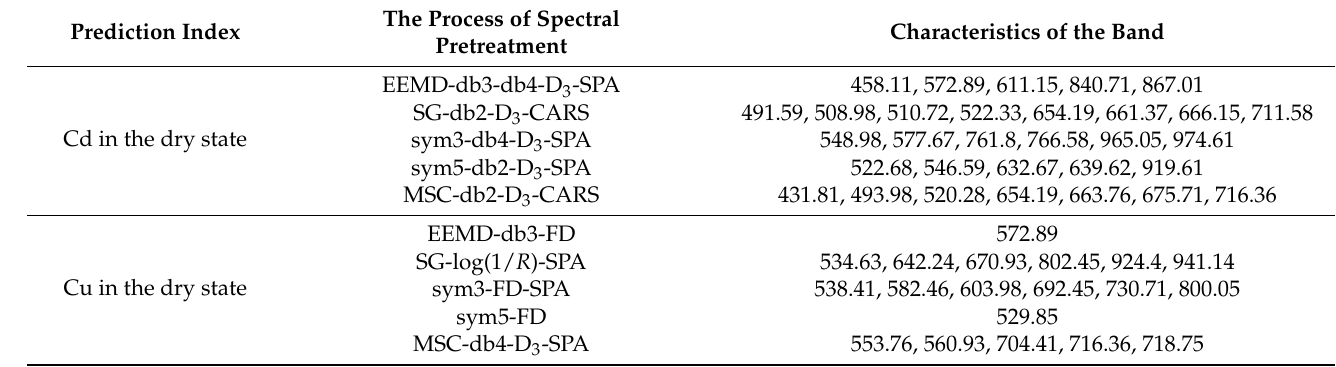
Table 3. The corresponding spectral preprocessing method and the characteristic band of the